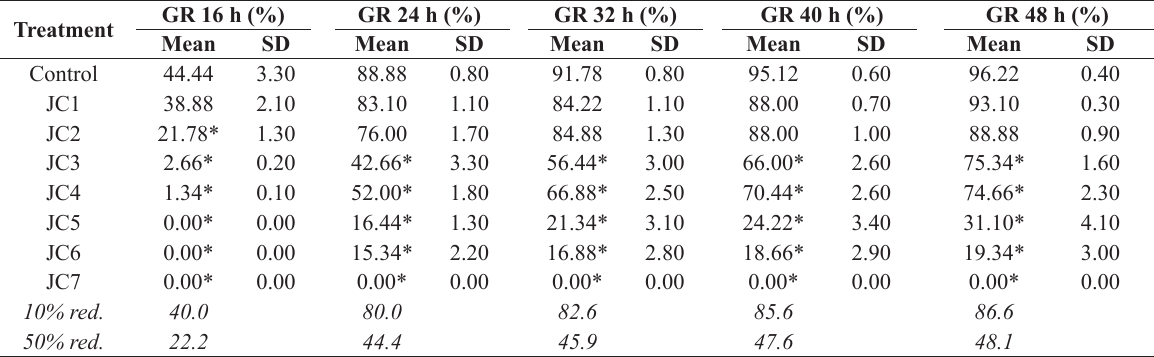
Germination Rate (GR) in L. sativa after J. curcas oil exposure.